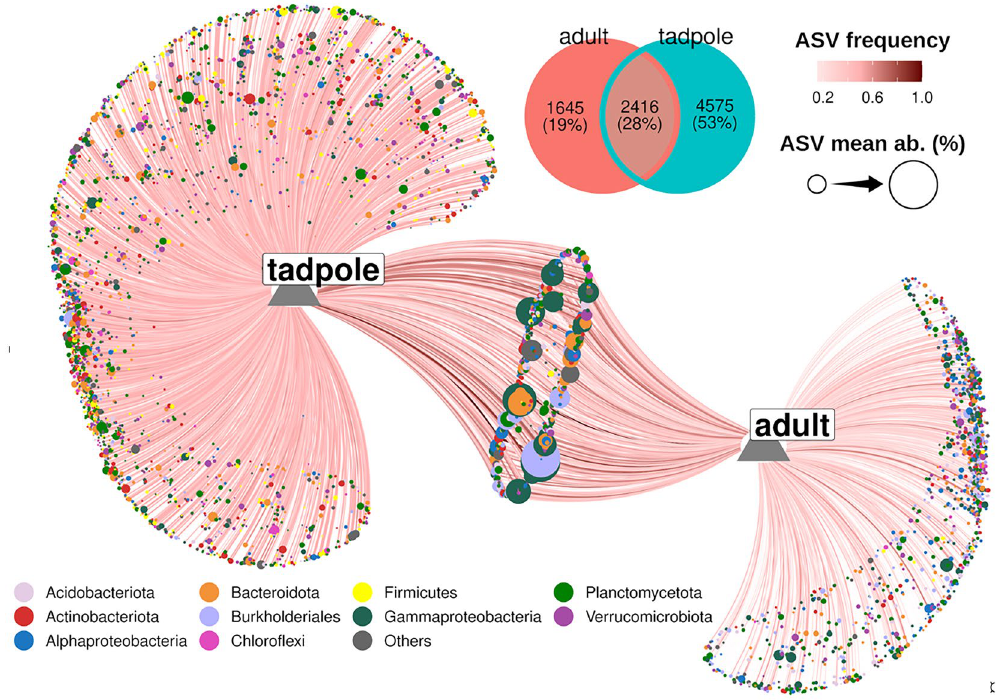
Figure 4. Skin microbiome composition of N. adenopleura at the tadpole (n = 18) and adult (n = 13) life stages caught at the same time in the same location and habitat. Only ASVs occurring in at least 3 different samples are visualized in the network. The size of each node corresponds to the mean relative abundance of an ASV in the considered samples, while the colour indicates the ASV’s taxonomic affiliation. The node size corresponds to ~ 4% for the largest circles to ~ 0.001% of the smallest ones (i.e. larger nodes are shared and smaller are unique but also highly variable among individuals). The Venn diagram shows the size of the unique and shared node